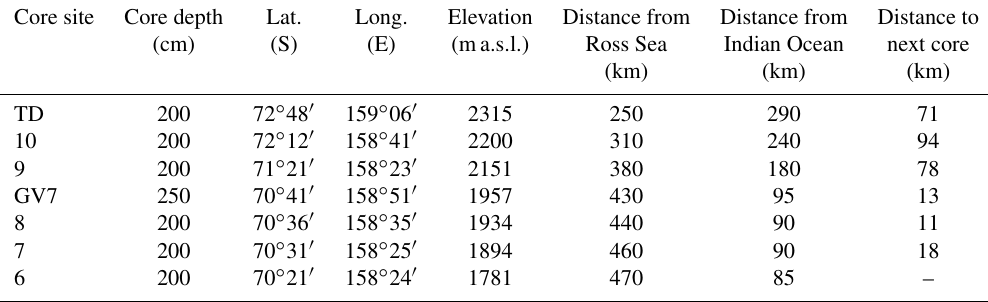
Table 1. Core drilling site information. Core